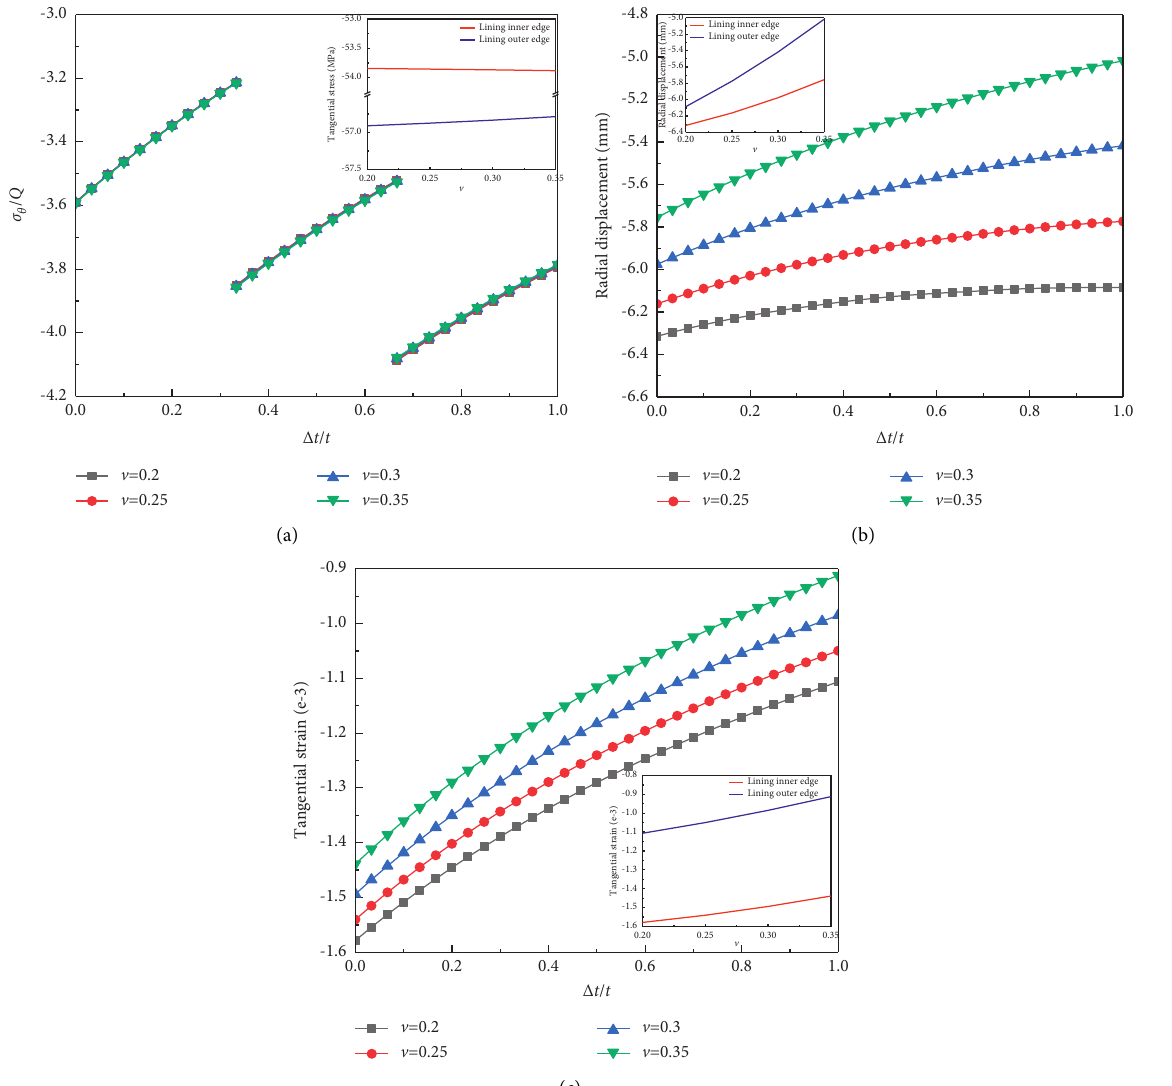
Figure 7: Variations in tangential stress, radial displacement, and tangential strain of FGL with Poisson’s ratio ] . (a) Tangential stress. (b) Radial displacement. (c) Tangential